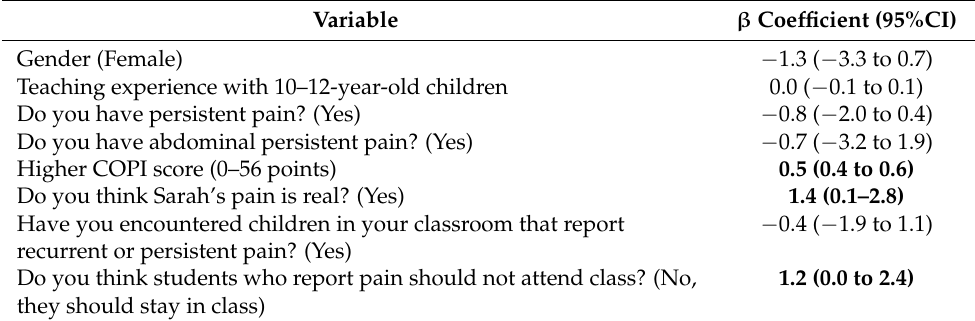
Table 5. Results of univariate regression analyses between higher COPI-Proxy total scores (n = 233) and other